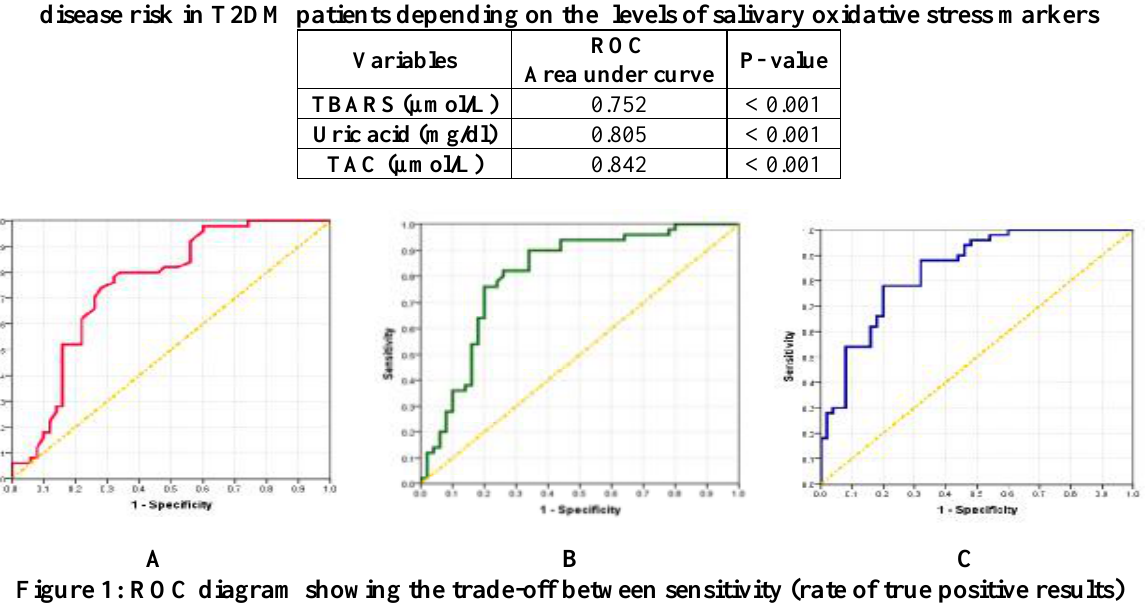
Table 2: Area under receiver operator characteristic (ROC) curve for prediction of vascular disease risk in T2DM patients depending on the levels of salivary oxidative stress markers